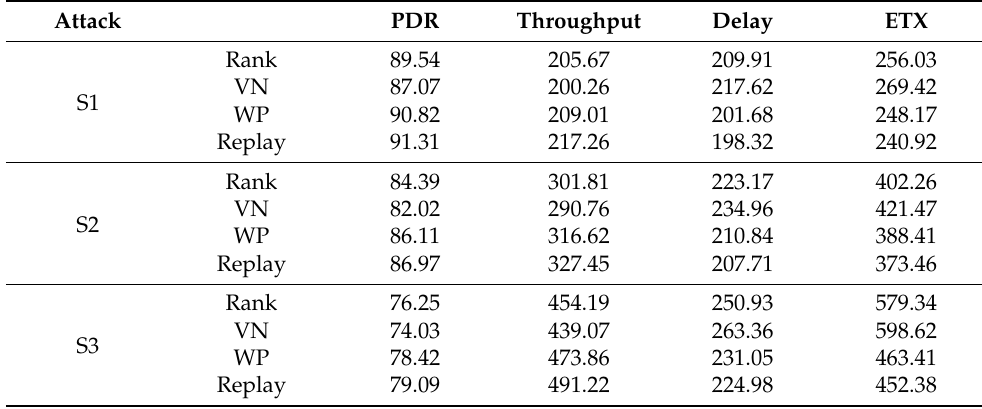
Table 4. QoS Performance Results: Single-Attack